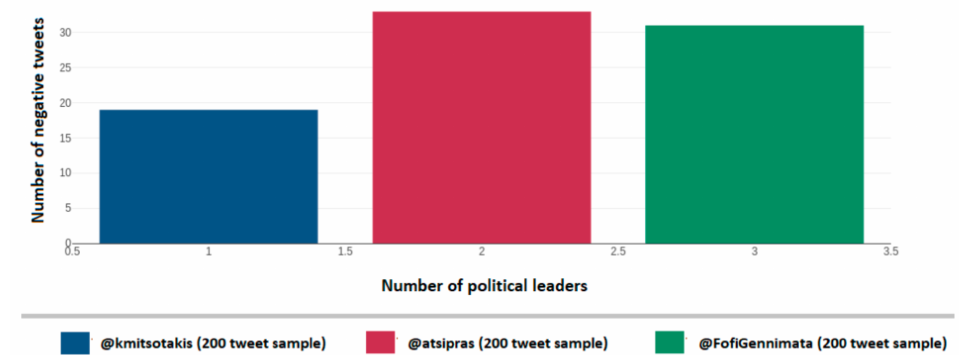
Figure 29. Negative identified tweets for the top three Greek pollical leaders (600 tweet